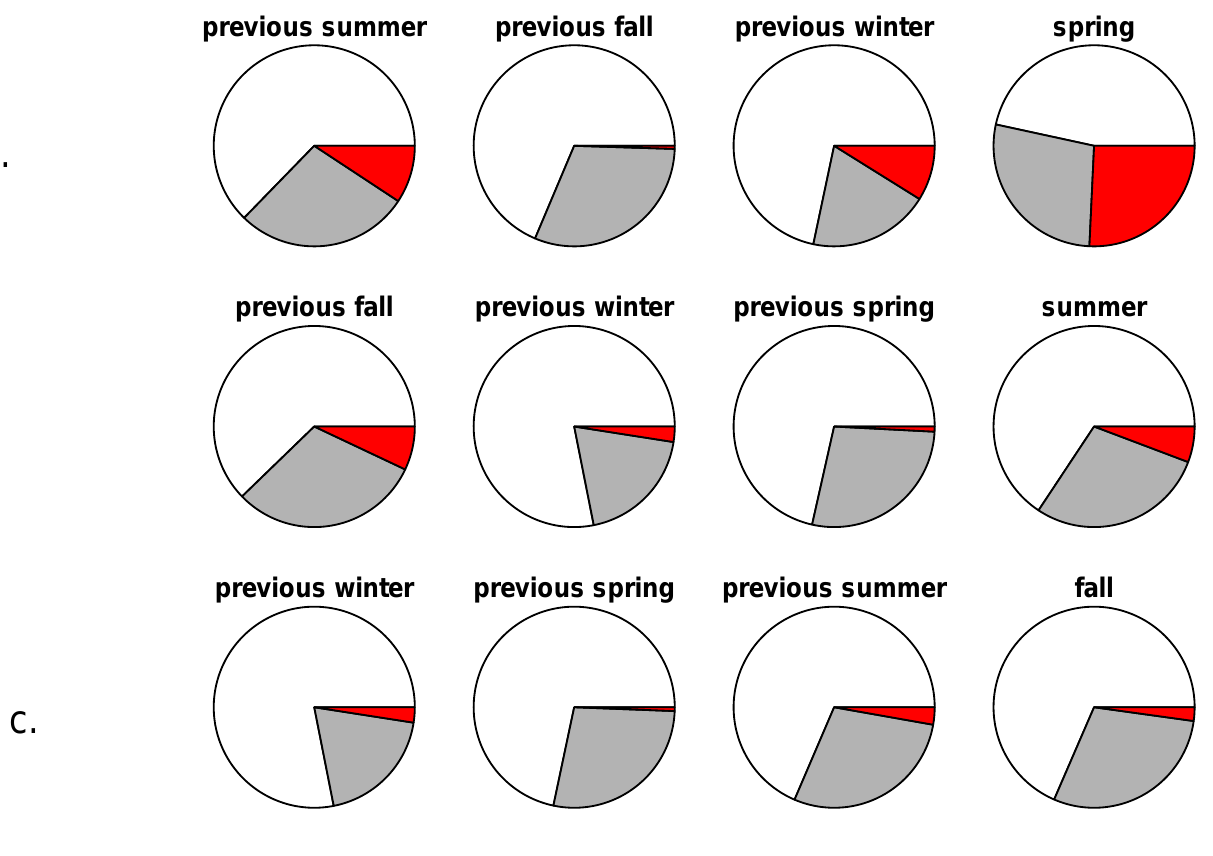
Figure 5. Pie charts illustrating differences in the proportion of ignition and non-ignition locations experiencing a high-air-temperature month in the 3 seasons previous to and including the spring (Panel a ), summer (Panel b ), and fall (Panel c ) fire seasons. The average proportion of non-ignition locations experiencing a high-Ta month in each season is illustrated in gray, and the proportional increase in ignition locations experiencing a high-Ta month in each season is shown in